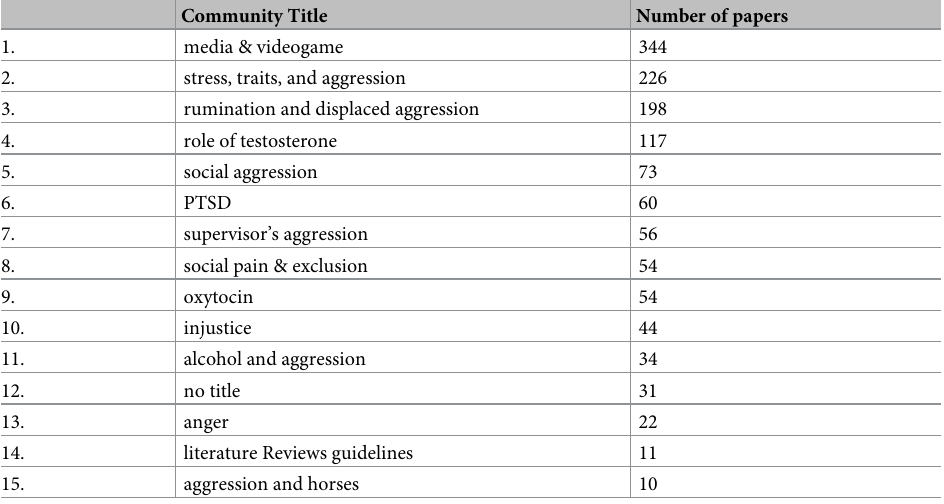
Table 2. The titles for the communities with at least 10 papers are reported in this table along with the number of papers contained in each community. See the Section B in S1 File, for additional